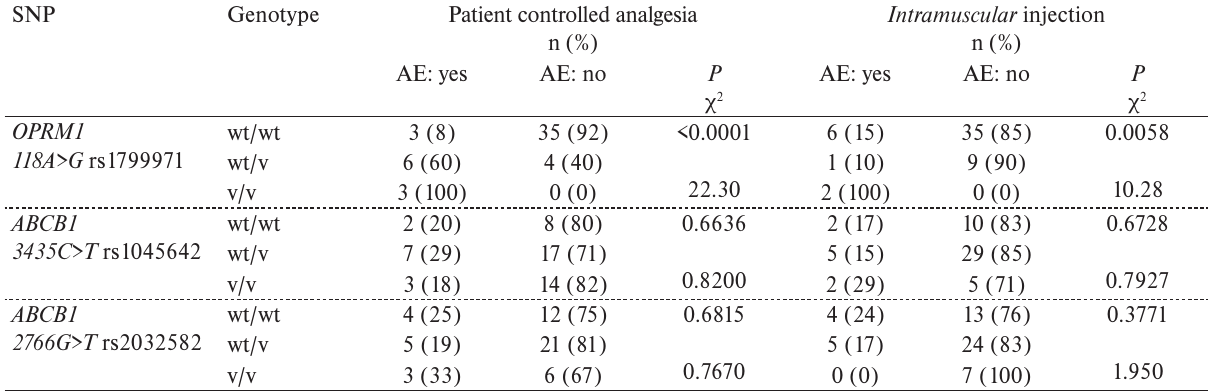
Table 4. Incidence of opioid-induced adverse effects according to